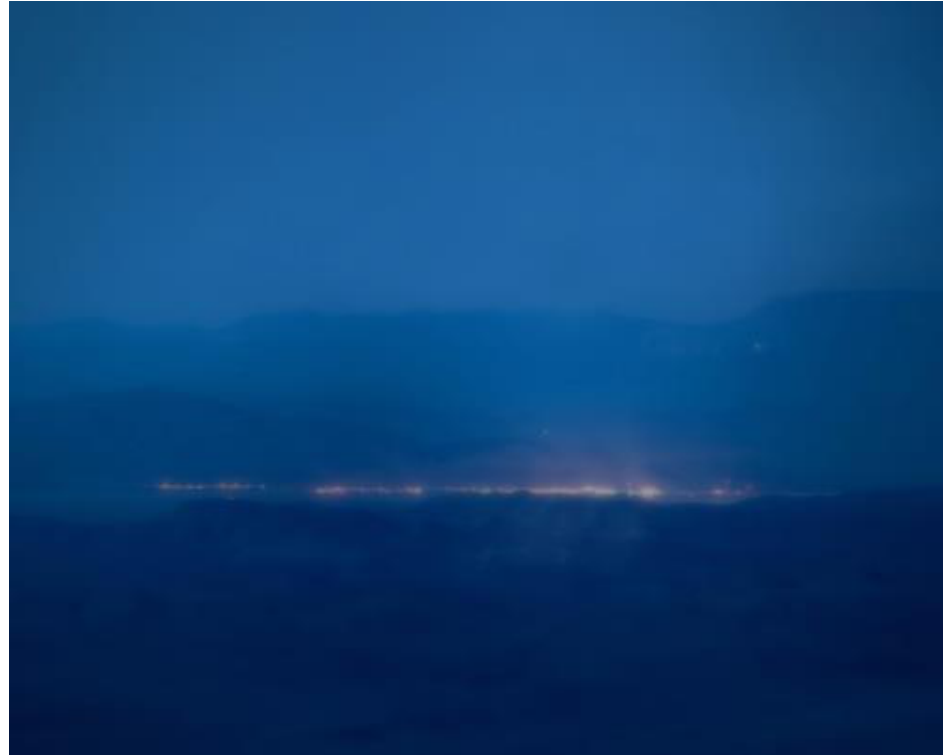
Trevor Paglen, Detachment 3, Air Force Flight Test Center, Groom Lake, NV Distance approx. 26 miles , from the Limit Telephotography series, 2008. C-print, 40 x 50 in. Copyright Trevor Paglen, courtesy the artist and Metro Pictures, New York; Altman Siegel, San Francisco.